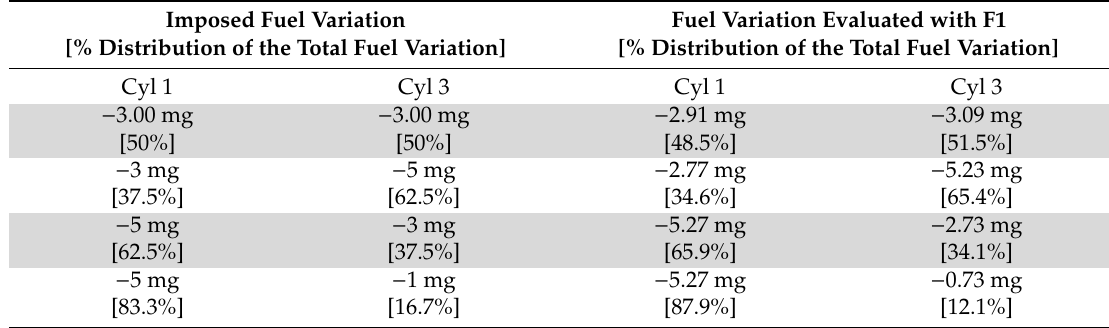
Figure 3. Representation in the complex plan of order F1 in case of injection variations in each cylinder singularly, in case of same injection variations in two cylinders consecutive in the firing order, and in case of random injection variations in two cylinders consecutive in the firing order (focus on the negative imaginary part). Engine operating conditions: 3000 rpm. Data from [31]. Table 1. Imposed and calculated variation of injected fuel in one cylinder and in the case of random injection variations in two consecutive cylinders in the firing order. Data from [31].